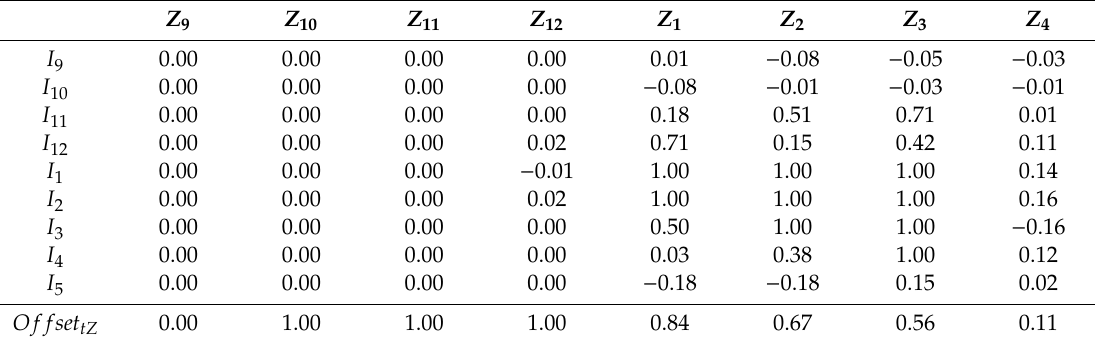
Table 5. The weight matrix and parameter of training results of